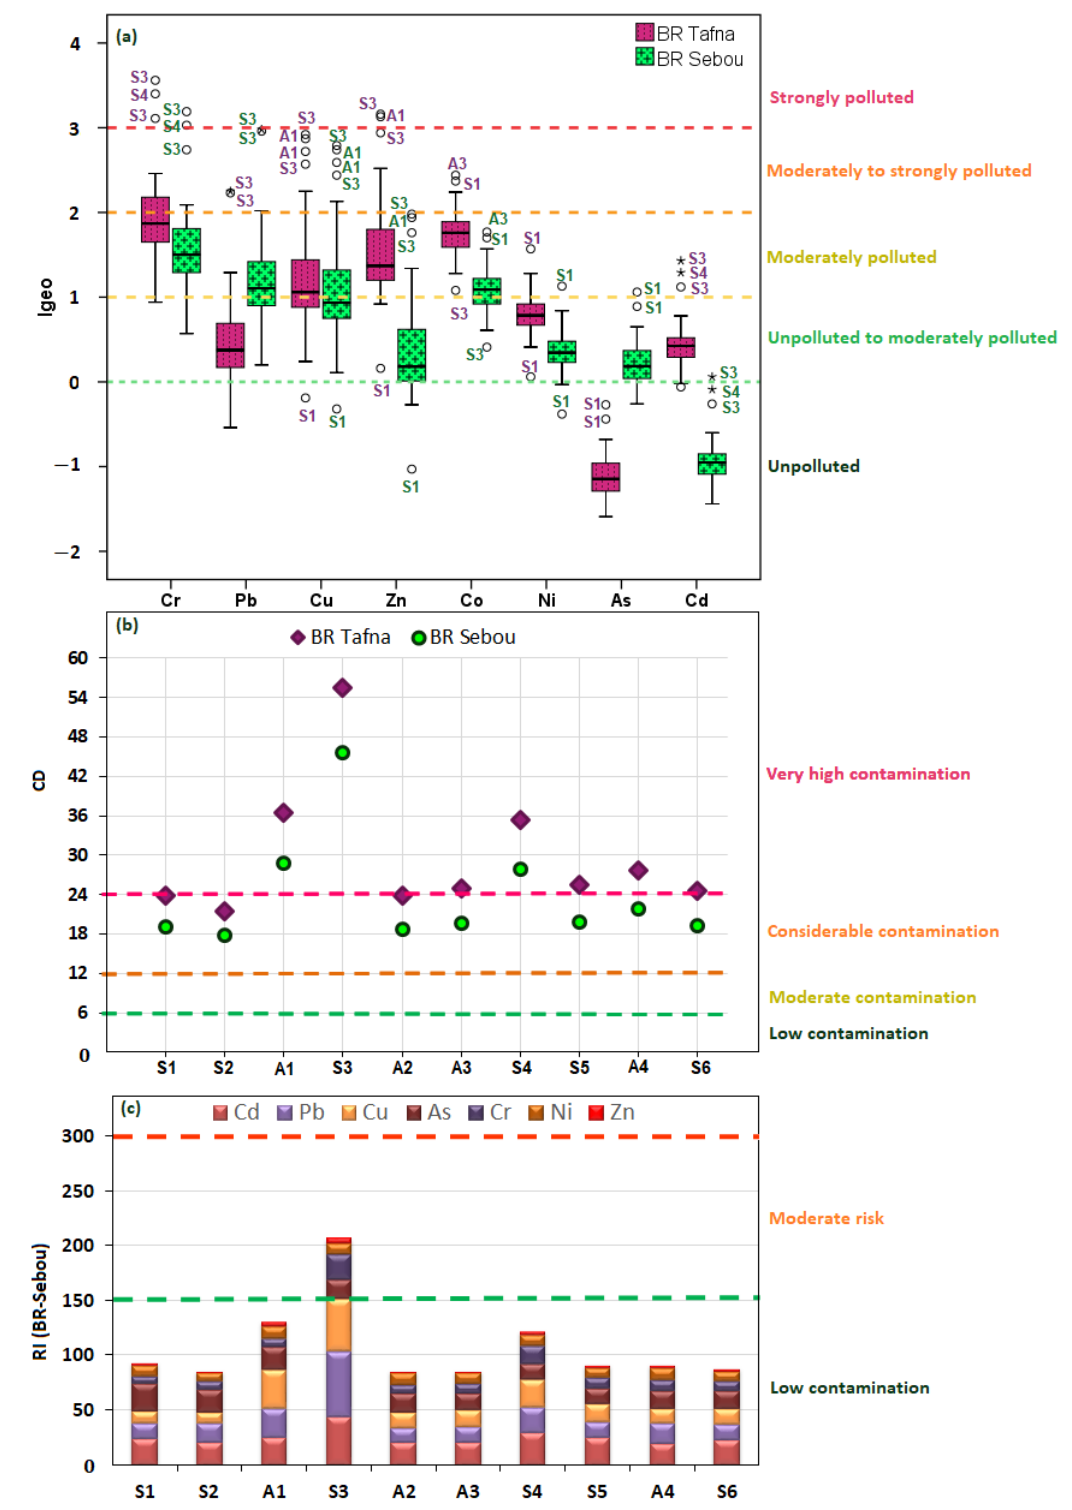
Figure 5. Contamination indices of trace elements in the Sebou River Sediments: ( a ) Geoaccumulation index calculated using the local bedrock (green boxplot: BR Sebou)) and the Tafna basin bedrock (pink boxplot: BR Tafna) [16]. The names of the sites for outlier data are indicated; ( b ) mean contamination degree (CD) per station identified using the local bedrock (circle) and the Tafna basin bedrock [16] (rhombus); ( c ) Mean potential ecological risk (RI) per station using the local bedrock (BR-Sebou).